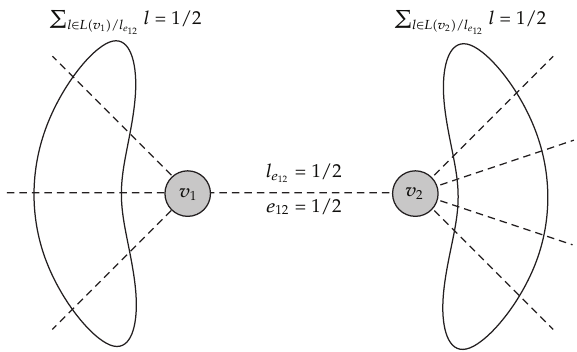
Figure 3: Example of node-label-constraints for sets of two nodes (cid:2) 3.23 (cid:3) dominating Inequalities (cid:2) 3.22 (cid:3) , that is, the node-label constraints for single nodes. For both nodes v i , i (cid:6) 1 , 2 it holds that Corresponding Inequality (cid:2) 3.23 (cid:3) is however violated, as